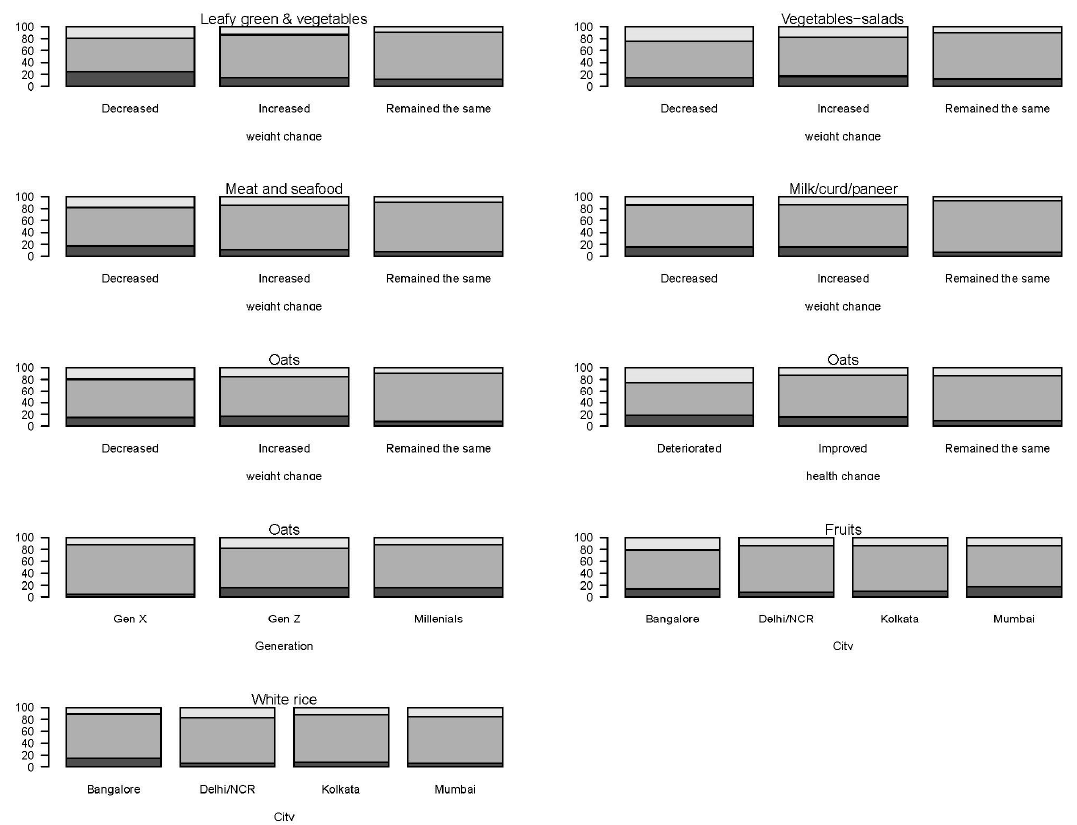
Figure 5. The percentage of participants reporting a decrease (dark gray), no change (medium-gray), or increase (light gray) during the COVID-19 confinement compared to pre-COVID-19 in dietary intake within self-reported body weight change, perceived health change, generation, and city if significant after multiple comparison adjustments ( q < 0.05).